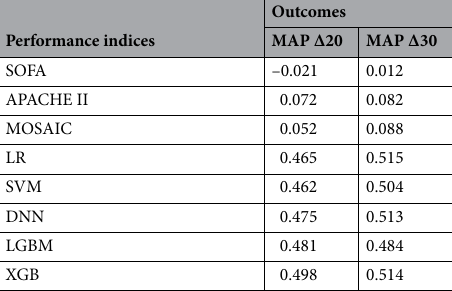
Table 2. Performance indices including accuracy, F1 score, and Matthews correlation coefficient of models in predicting hypotension within 6 h. MAP mean arterial pressure, MAP Δ20 reduction in MAP ≥ 20 mmHg from the initial value, MAP Δ30 reduction in MAP ≥ 30 mmHg from the initial value, SOFA Sequential Organ Failure Assessment, APACHE Acute Physiology and Chronic Health Evaluation, MOSAC Mortality Scoring